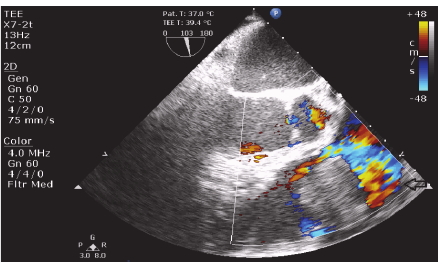
Figure 2: With the TEE on Doppler mode, we can estimate the tumour’s blood flow obstruction in the pulmonary artery.